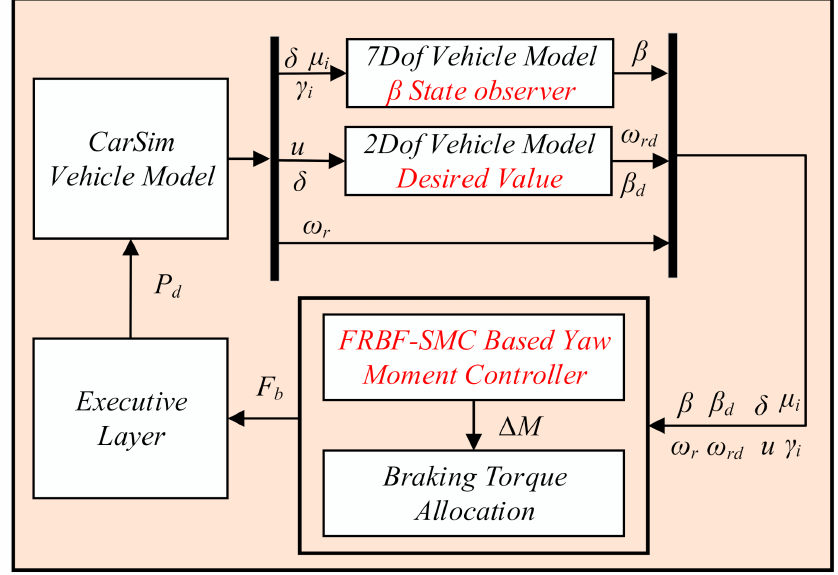
Figure 1. The overall structure of the vehicle dynamics stability